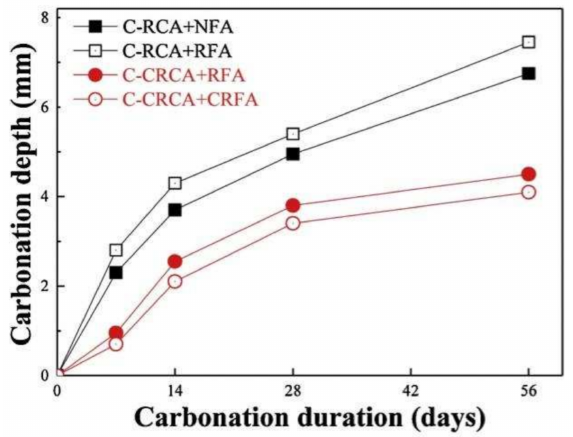
Figure 4. Carbonation behavior of CRA concrete exposed to carbonation